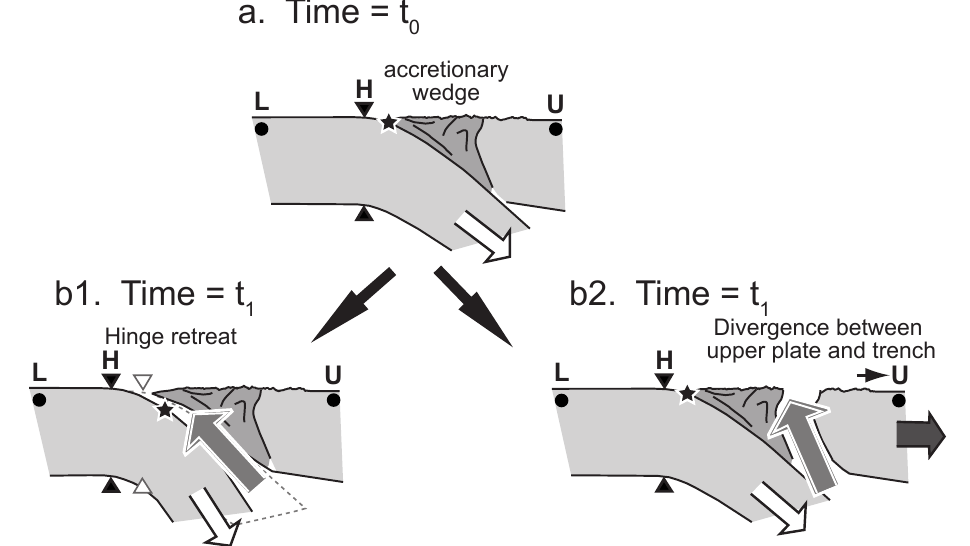
Fig. 6. Figure modified from Malus`a et al. (2011) showing a suggested difference in structural position of exhumed UHP units depending on the divergence of the upper and lower plates above the exhuming high-pressure rocks. (a) Subduction zone before exhumation. (b1) Retreat of subduction hinge, with high-pressure rocks exhumed on the lower plate side of the orogen. (b2) Upper plate motion away from the trench, with high-pressure rocks exhumed on the upper plate side of the orogen. L = lower plate, U = upper plate; black dots indicate fixed positions on those plates. H = subduction hinge.